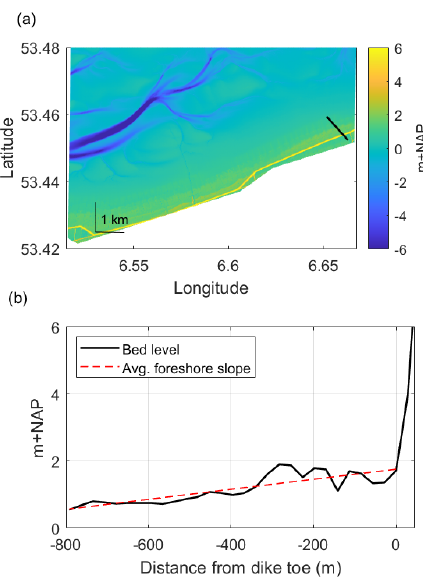
Figure 4. Subset of the Vaklodingen bathymetry dataset showing (a) a NW–SE-oriented transect at the field site location, Uithuizer- wad (black line), and (b) the corresponding cross-shore profile of this transect with the estimated average foreshore